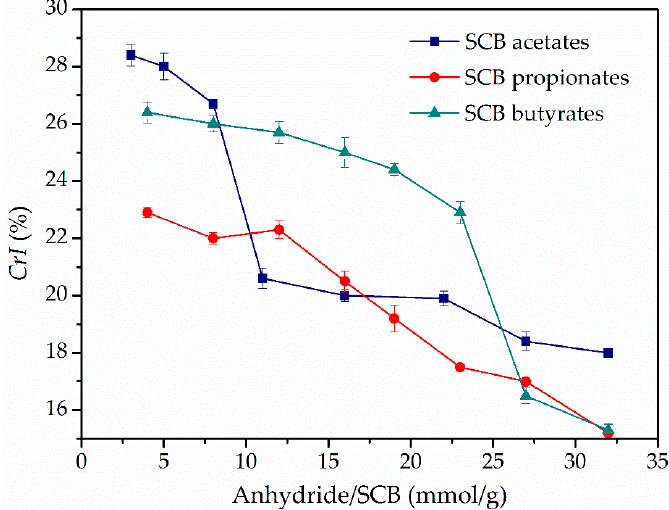
Figure 4. The CrI values of SCB acetates, propionates and butyrates at different anhydride/SCB